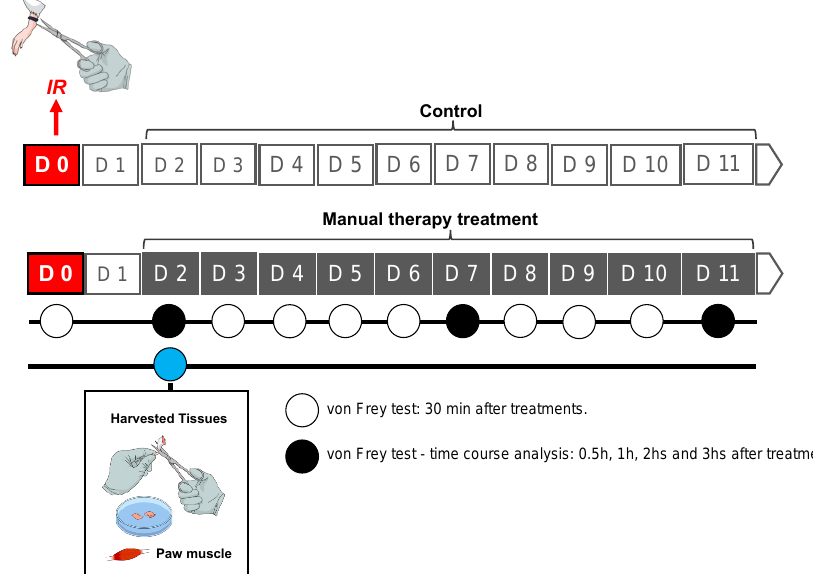
Figure 1. Timeline of treatment and analyses. Ischemia-reperfusion (IR): Ischemia and reperfusion; D: day; min: minutes; h: hour.